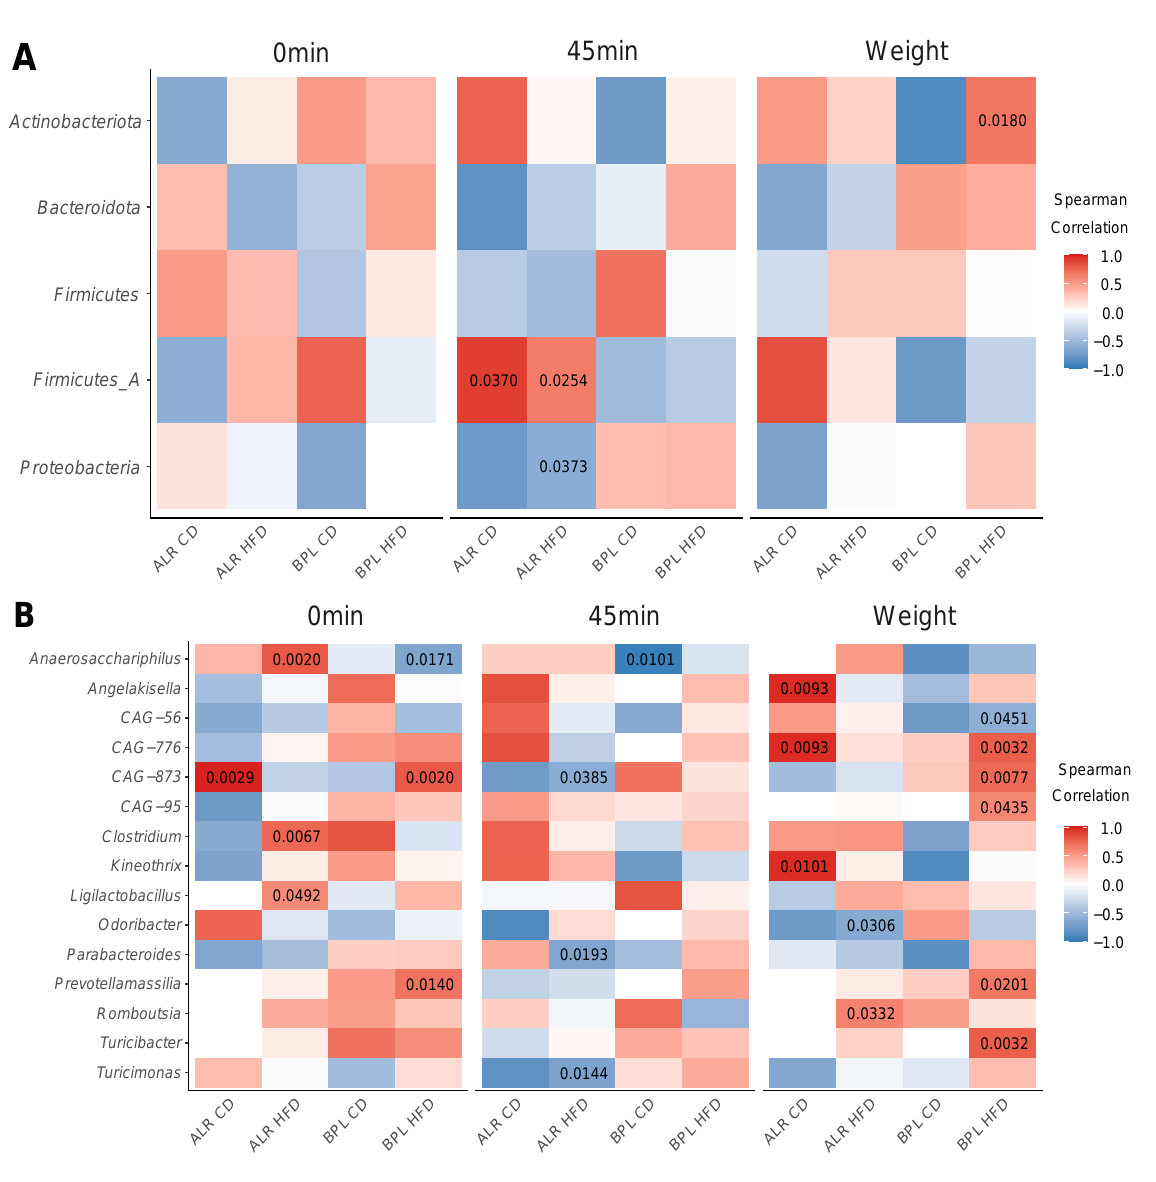
Figure 4. Correlation of bacterial phylum and genus with metabolic parameters. (Panel A ) shows the correlation with bacterial phyla and (Panel B ) are those with a genus. Correlation of bacterial abundance with fasting glucose levels (0 min), that with area glucose levels at 45 min after glucose injection in ipGTT (45 min), and that with body weight (Weight). p -values smaller than 0.05 are presented in the heat maps; only genera were included where the p -value was below 0.05 in at least one